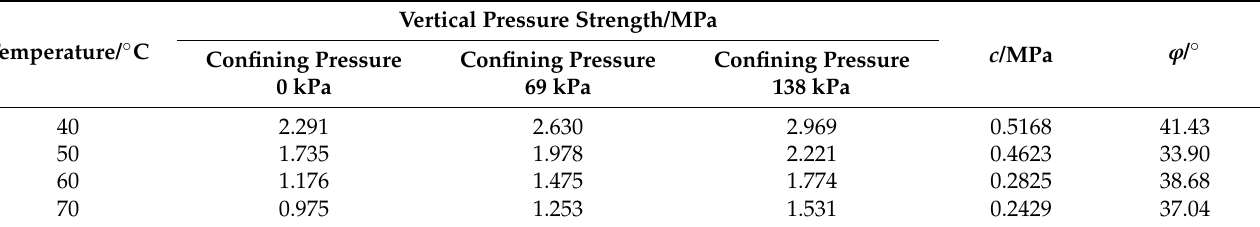
Table 1. Shear parameters of SBS asphalt mixture at different